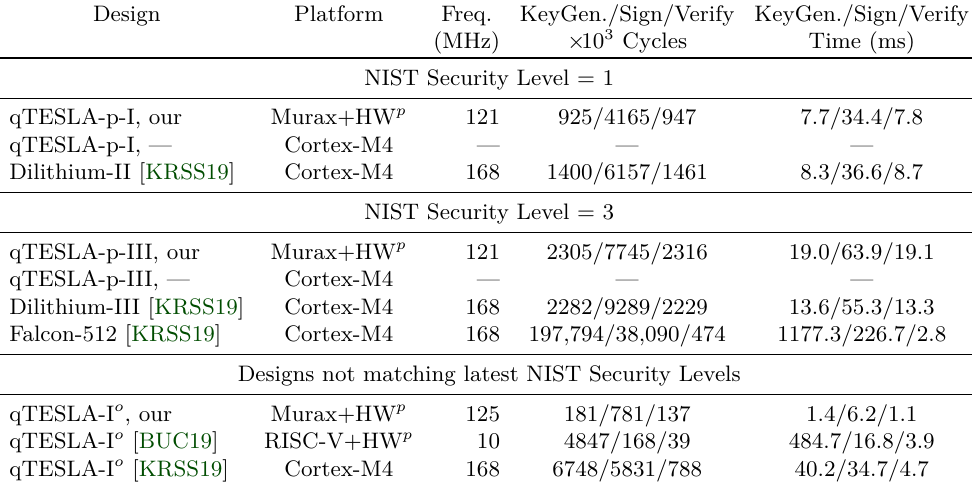
Table 12: Comparison with related work on lattice-based digital signature schemes for embedded systems. All the tests running on platform “Murax+HW” are based on the “ Murax + All ” design, see Section 4.3.3. o denotes the use of an old qTESLA reference implementation with outdated instantiations. Platforms noted with p are all synthesized on an Artix-7 AC701 FPGA. The “—” indicates the Cortex-M4 platform is not able to support qTESLA-p-I and qTESLA-p-III due to memory